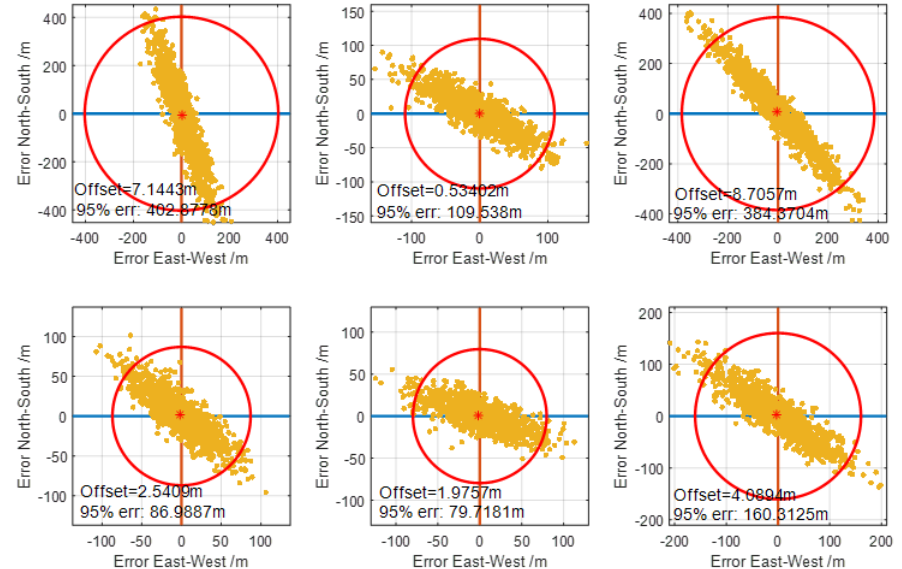
Figure 8. Scatter plot of position accuracy with complete difference, only including random noise in the pseudo-range. The upper three subgraphs are for three transmitters and the bottom three subgraphs are for four cases.